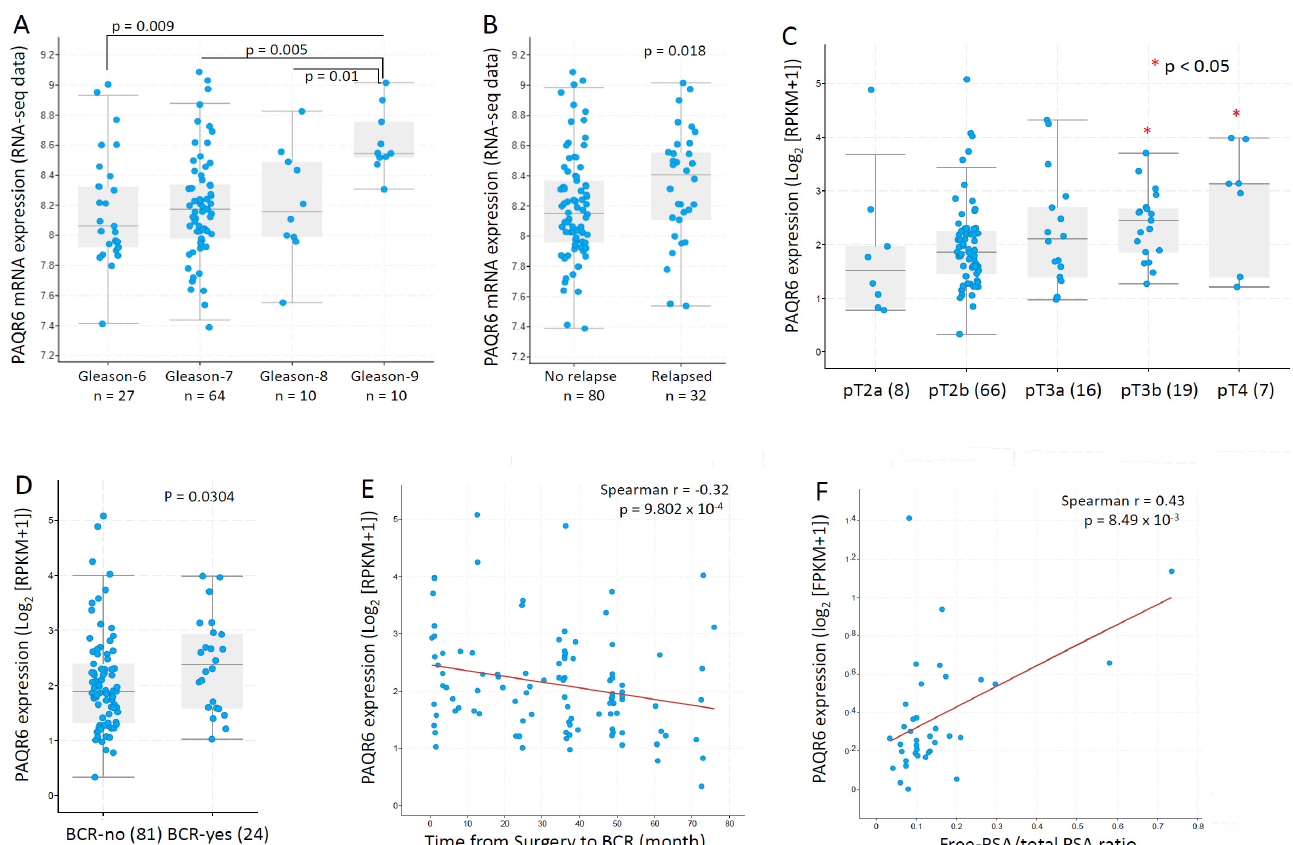
Figure 5. PAQR6 expression was associated with tumor TNM stages, Gleason score, and disease relapse in prostate cancers. PAQ6 expression levels in different patient groups as divided by Gleason scores (panel A ), disease relapse status (panel B ), pathological stages (panel C ), and biochemical relapse (panel D ) were assessed using the RNA-seq dataset generated from primary prostate cancer tissues [23]. The correlation between PAQR6 expression levels and progression-free interval (panel E ) or serum PSA levels (panel F ) were analyzed using the RNA-seq dataset generated from treatment-naïve prostate cancer tissues [29]. The figure images were generated on the cBioportal platform. Case numbers in each group were shown at the bottom of the figures.